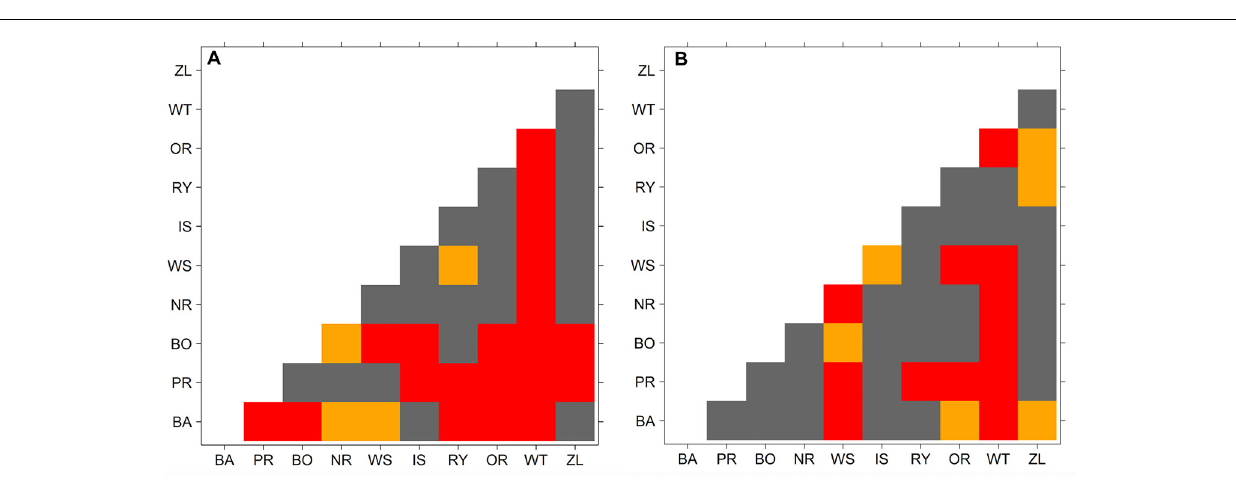
FIGURE 6 | Probability value of Wilcoxon rank-sum test used to demarcate a significant difference in PCGA-ranks between provenances. Colors represent significance level of Wilcoxon rank-sum test (orange: p < 0.05, red p < 0.01, gray non-significant). Panel A – Knyszyn (KN) site, panel B – Kórnik (KR)